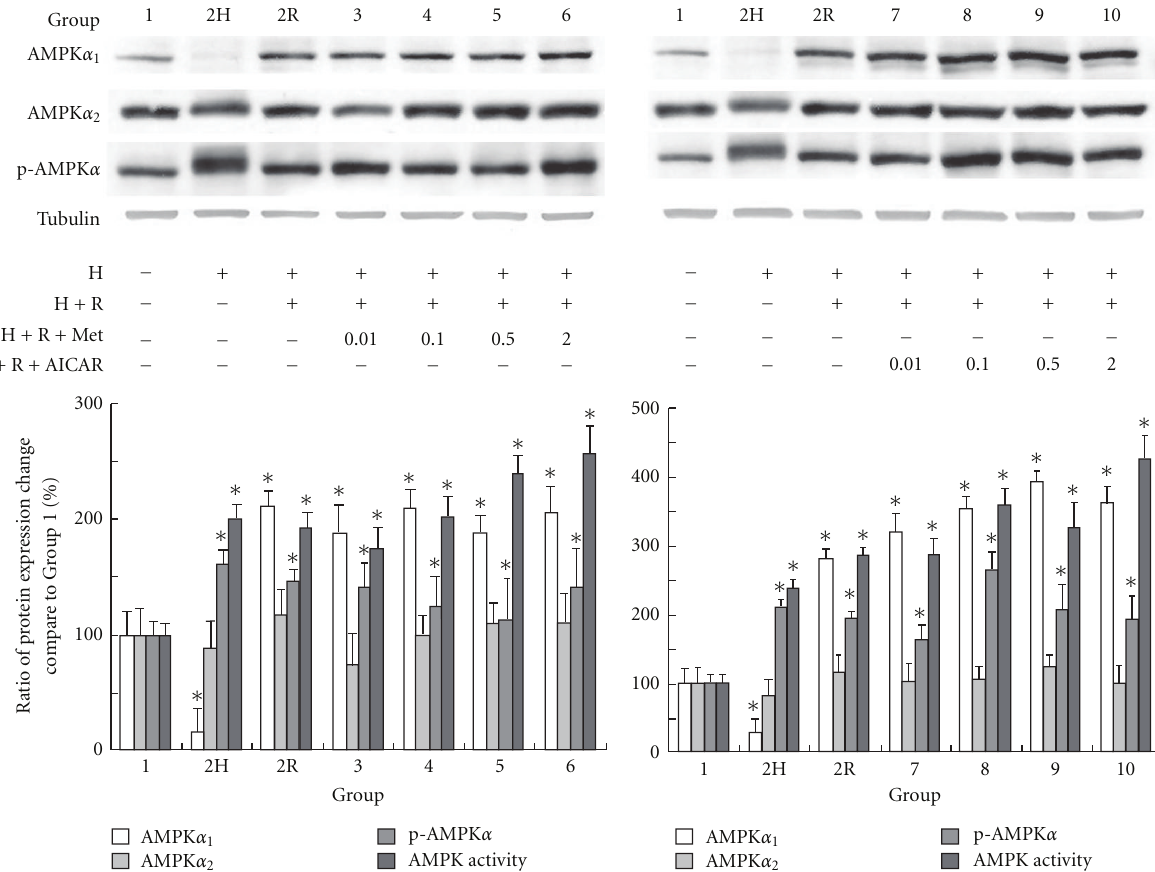
Figure 1: The results of western blot analysis of AMPK α 2 , AMPK α 2 , and p-AMPK α and AMPK activities in di ff erent groups are shown. Tubulin was used as internal control. (Results are representative of at least 3 separate experiments. ∗ P < . 05 compared with Group 1; H: hypoxia; R: reoxygenation; Met: